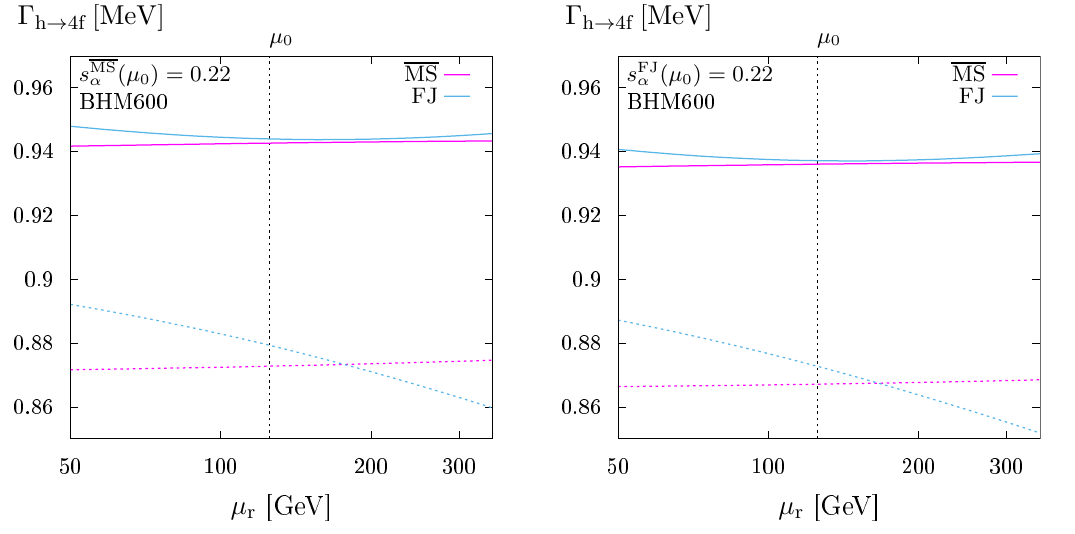
Figure 17 . Scale dependence of the decay width (cid:0) h ! 4 f at LO (dashed curves) and NLO EW+QCD (solid curves) for benchmark scenario BHM600, using the central scale (cid:22) 0 = M h . On the left (right) the input parameters are de(cid:12)ned in the MS (FJ) scheme and converted to the FJ (MS) scheme at the scale (cid:22) 0 (both for LO and NLO predictions).